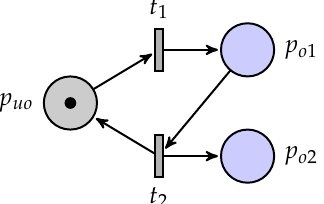
Figure 1. A partially observed unbounded Petri net.